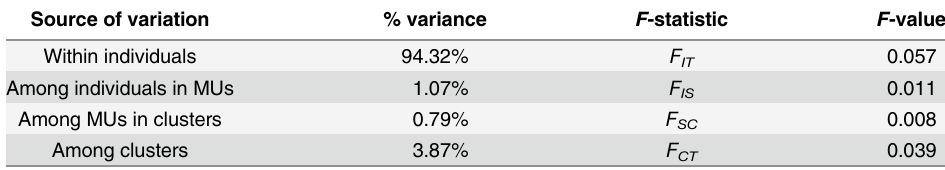
Table 3. Hierarchical analysis of molecular variance (AMOVA) for nuclear microsatellites among man- agement units within the six genetic clusters identified in this paper and shown in Table 2. For this analysis, we followed Peacock et al ., 2015 [20] by including northern Davis Strait in the Eastern Archipelago cluster and southern Davis Strait in the Hudson cluster. Western Laptev was included in the Western Basin cluster and Eastern Laptev was included in the Eastern Basin cluster. However, results did not differ signifi- cantly when the Laptev Sea and Davis Strait MUs were excluded entirely. Source of variation % variance F -statistic F -value Within individuals 94.32% F IT 0.057 Among individuals in MUs 1.07% F IS 0.011 Among MUs in clusters 0.79% F SC 0.008 Among clusters 3.87% F CT 0.039